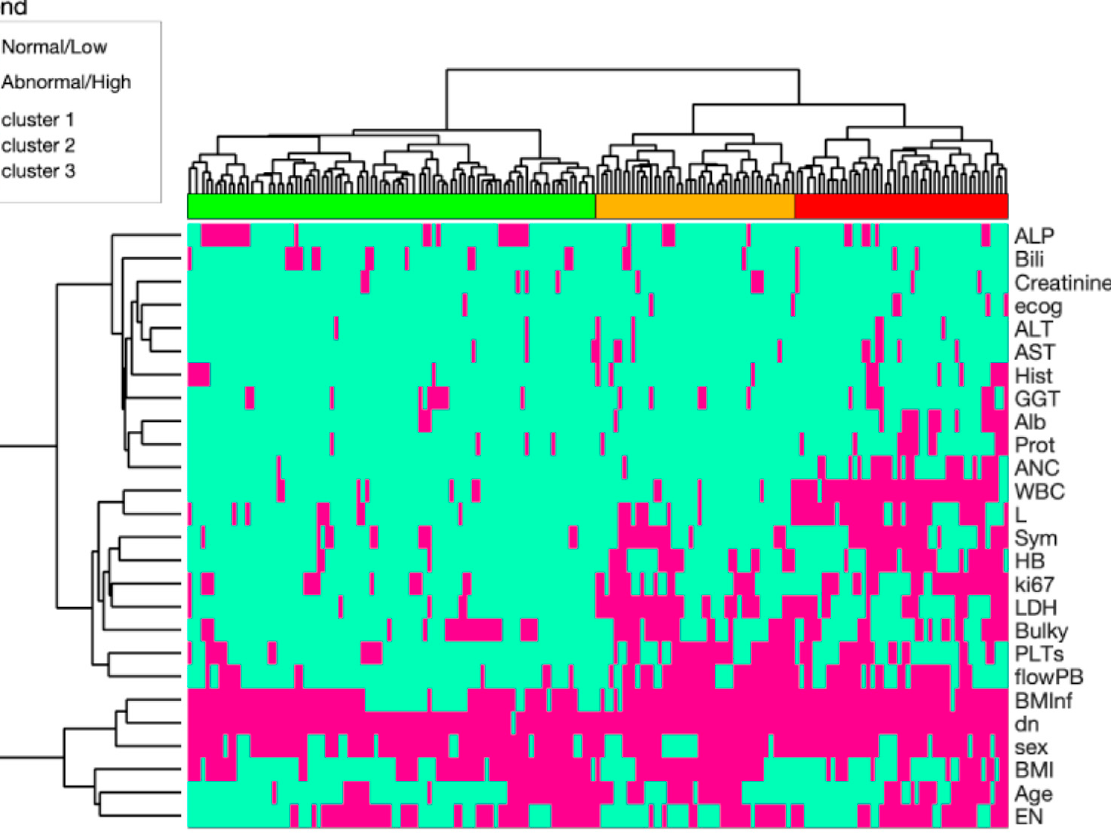
Figure 1. Heat-map of potential prognostic factors for MCL, based on a cluster analysis on training dataset. Light green cells represent either normal or low values of the indicated variables; magenta cells represent either abnormal or high values of the indicated variables. Three large clusters emerged that were associated with Low (green, C1), Intermediate (orange, C2), and High (red, C3) risk. Abbreviations. ALP: alkaline phosphatase; Bili: bilirubin, ecog: performance status; ALT: alanine aminotransferase; ASP: aspartate aminotransferase; Hist: histology; GGT: gamma glutamyl-transferase; Alb: albumins; Prot: total proteins; ANC: absolute neutrophil count; WBC: white blood cell count; L: lymphocytes; Sym: B symptoms; HB: hemoglobin; ki67: cell proliferation marker; LDH: lactate dehydrogenase; PLTs; platelets; flowPB: lymphoma involvement, revealed with flow-cytometry analysis of peripheral blood; BMInf: tumor infiltration, assessed with immunohistochemistry on bone marrow biopsies; dn: nodal involvement, based on a computerized tomography scan; BMI: body mass index; EN: extranodal involvement, based on computerized tomography scan. Taken together, the eMIPI produces the most balanced groups of patients (Low risk: 31%, Int risk: 30%, and High risk: 39%), when compared to the distributions produced with the MIPI-st (Low: 59%, Int: 29%, and High: 17%) and the MIPI-b (Low: 26%, Int: 62%, and High: